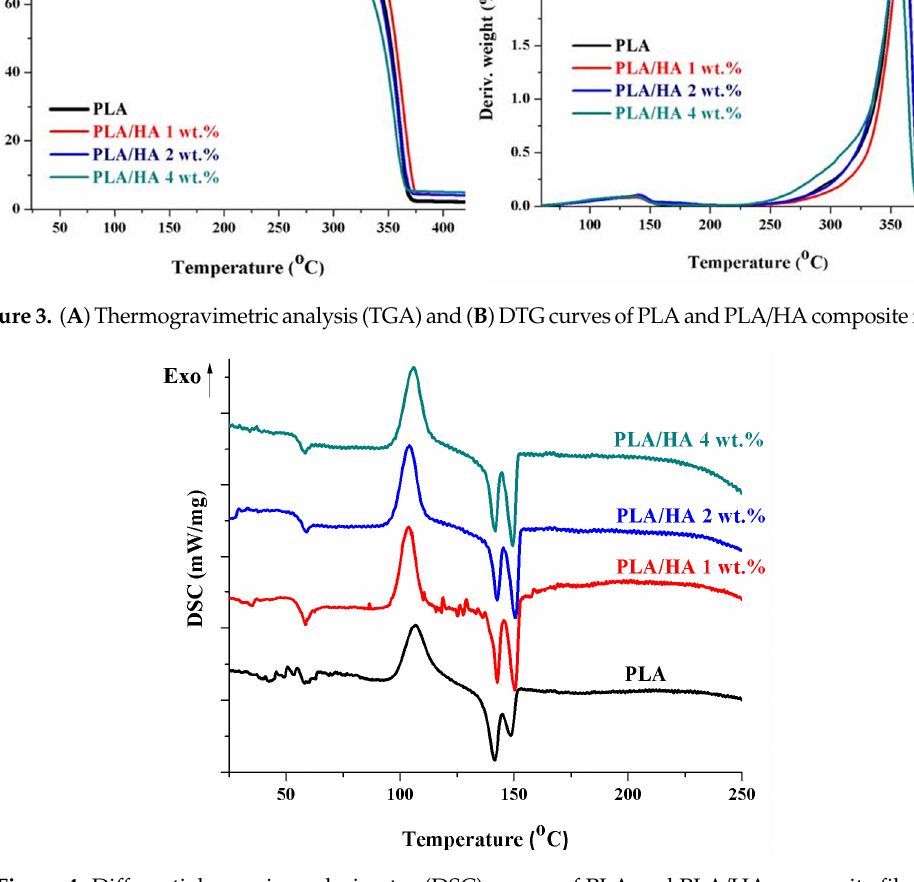
Figure 4. Di ff erential scanning calorimetry (DSC) curves of PLA and PLA / HA composite films. Figure 4. Differential scanning calorimetry (DSC) curves of PLA and PLA/HA composite films. Table 1. Thermal characteristics of obtained materials (where Tm1 and Tm2 are melting temperatures for low respectively high-temperature endotherms, ∆ Hc is crystallization enthalpy of the sample and ∆ Hm is melting enthalpy of the